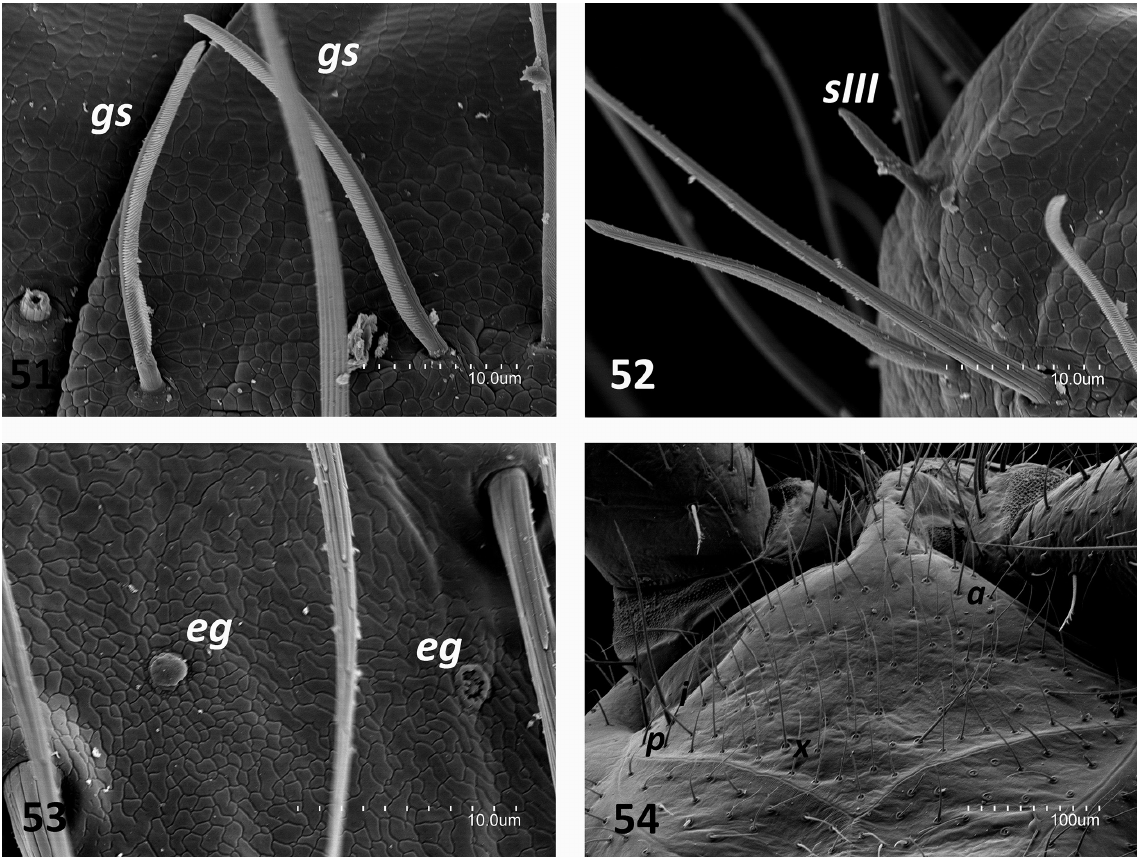
Figs 51‒54. Pacificampa wudonghuii Sendra sp. nov. 51 . Gouge sensilla ( gs ) of antennomeres. 52 . Sensillum of the third antennomeree ( sIII ). 53 . Surface of the notum with external glands ( eg ). 54 . Frontal process with anterior ( a ), intermediate ( i ) and posterior ( p ) macrosetae of the insertion line of antennae and x